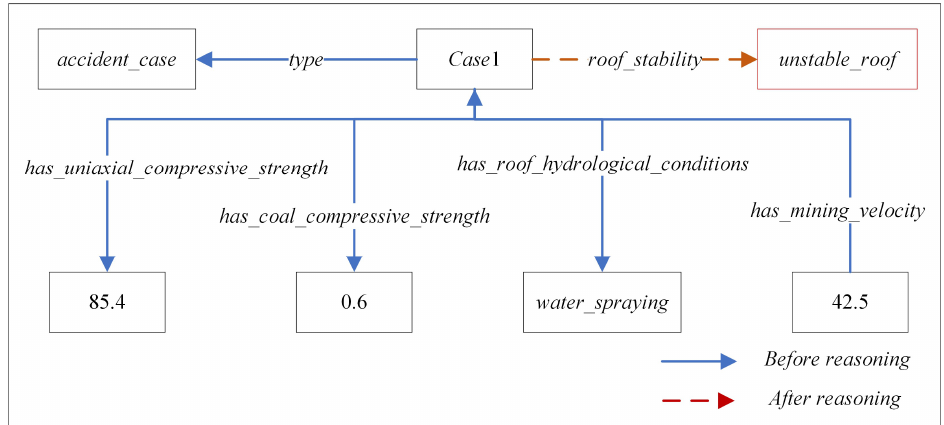
Figure 13. Inference chain for roof stability.